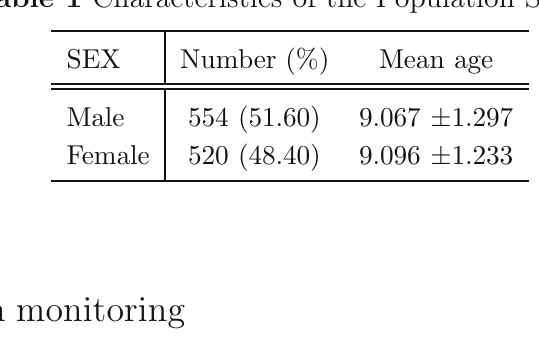
Table 1 Characteristics of the Population